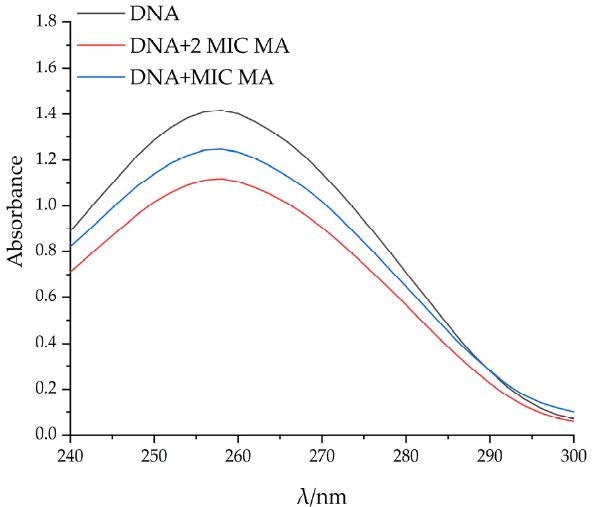
Figure 8. The absorption spectrometric titrations of MA with DNA.